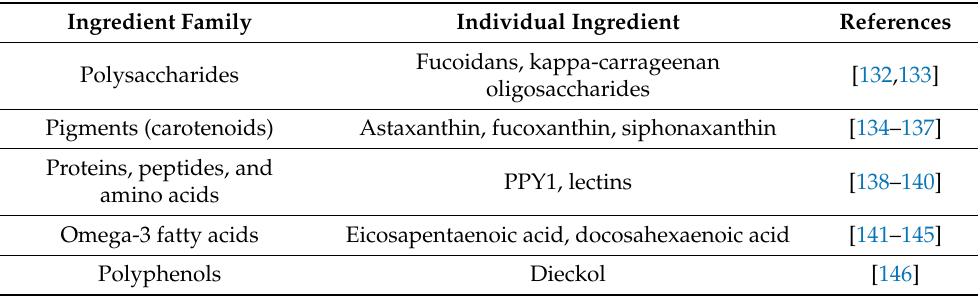
Table 3. Summary of the potential marine-derived compounds that could be used as functional food ingredients against neuroinflammatory